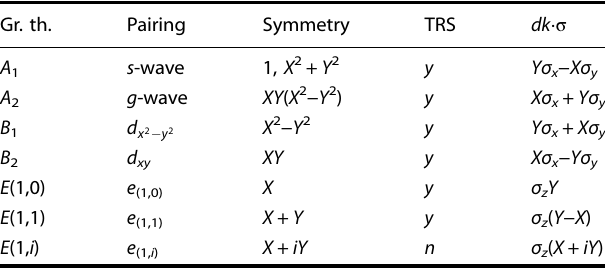
Table 1. Possible pairing states for a system with C 4 v point group such as thin layers of Sr 2 RuO 4 Gr. th.